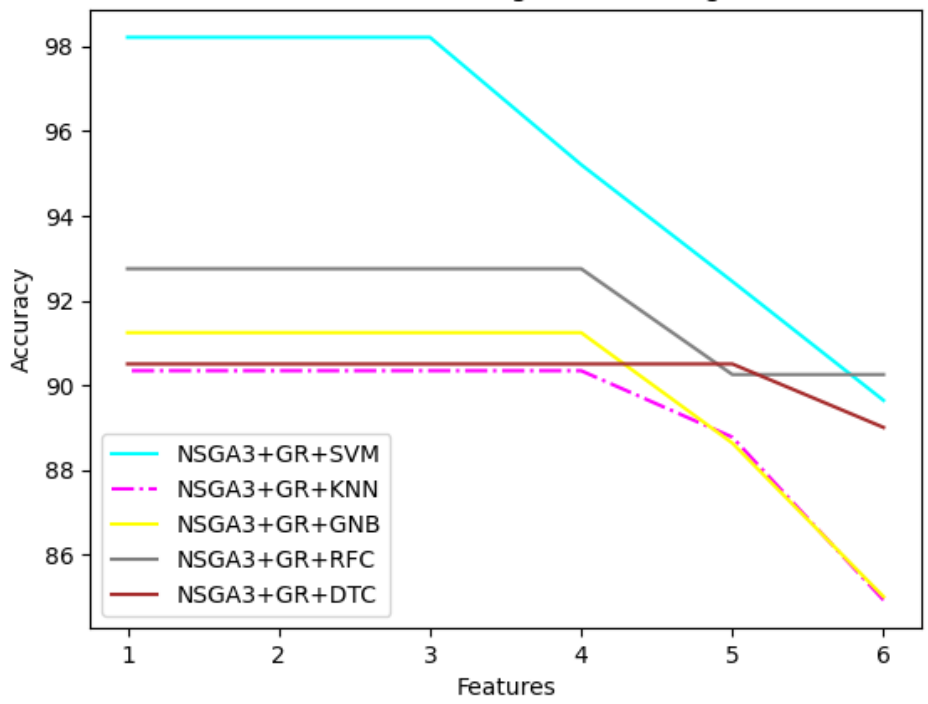
Figure 5. NSGA3 + GR with various